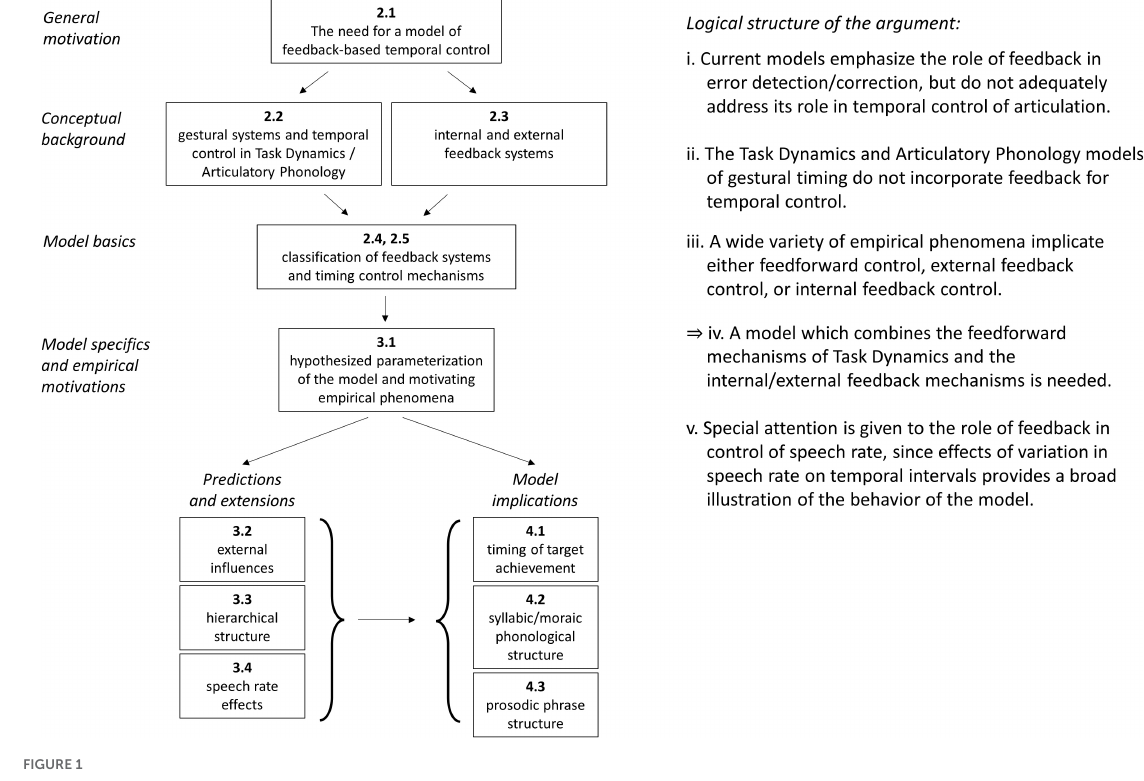
mathematical model. All model equations and